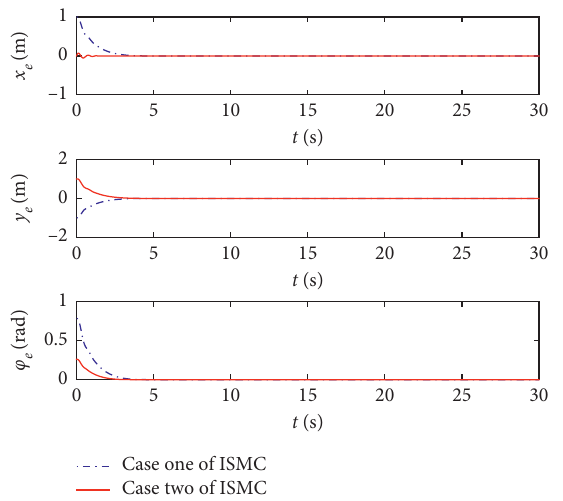
Figure 4: Position tracking errors on ISMC with different conditions.